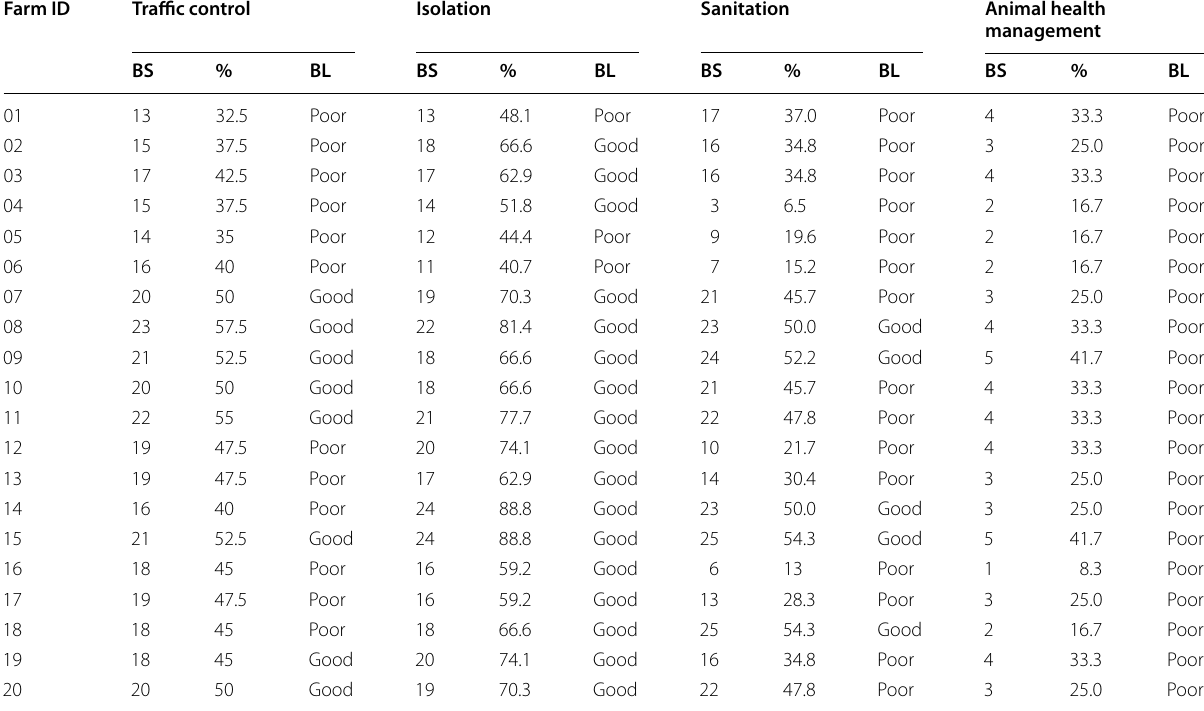
Table 8 Component specific biosecurity score, percentage and level implemented by dairy